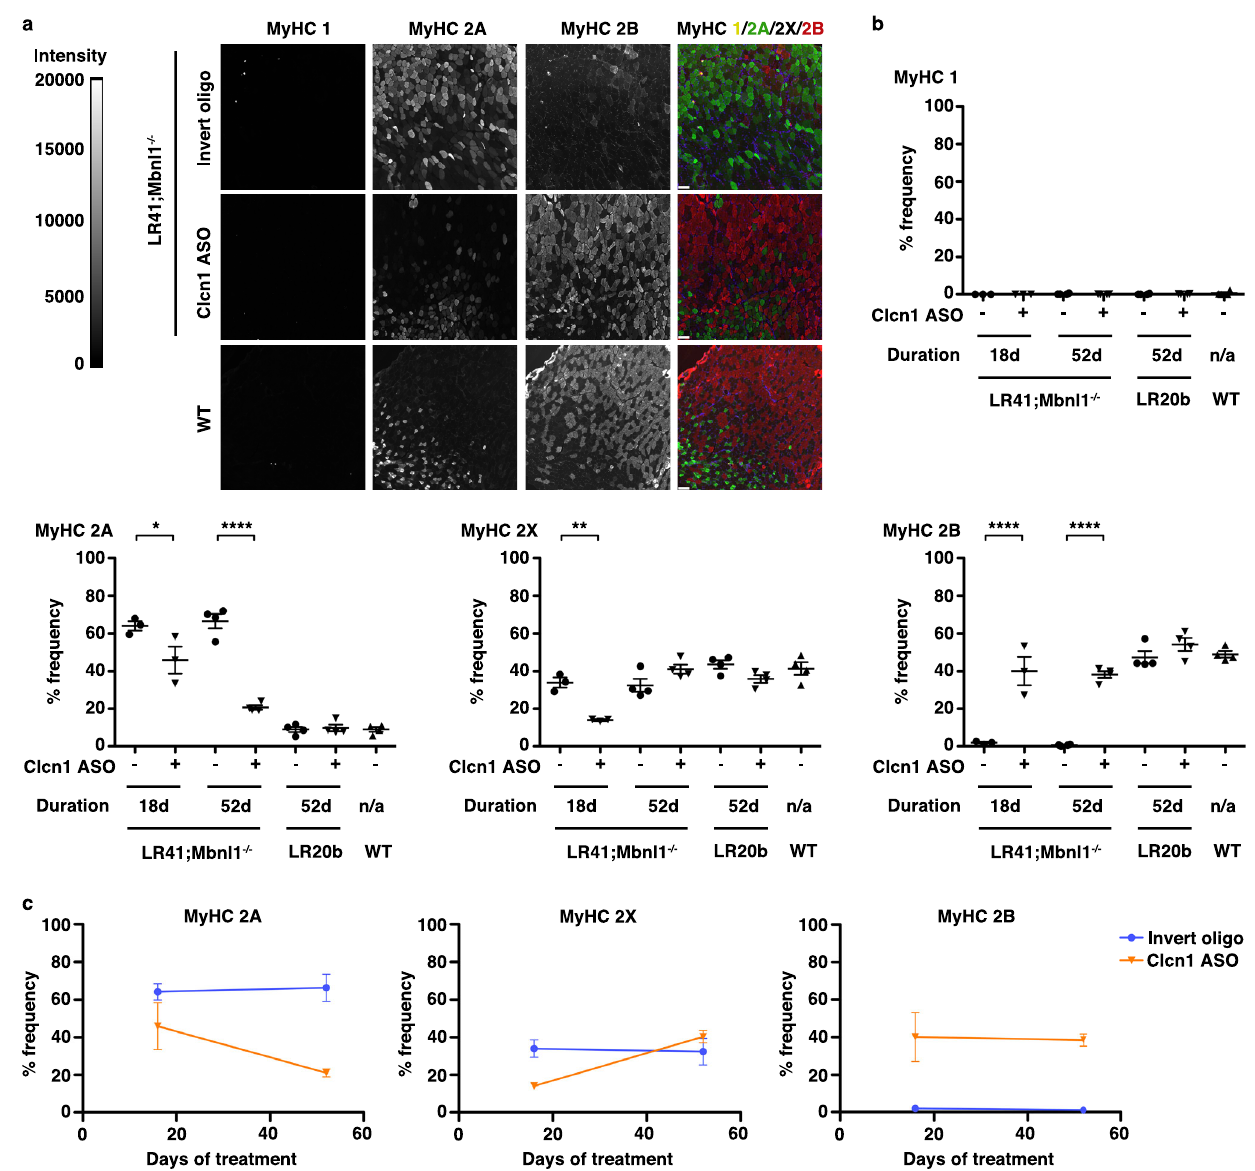
Fig. 3 | Reversal of myosin fi ber type transition in ASO-treated LR41; Mbnl1 − / −